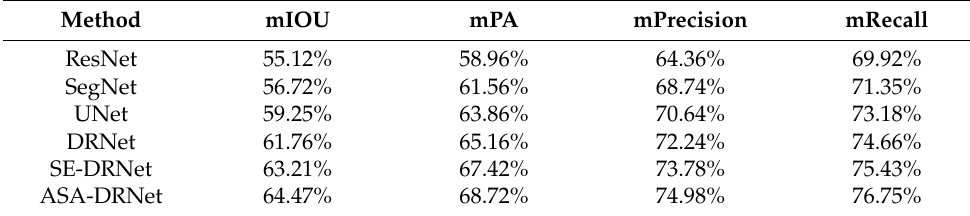
Table 3. Comparison of different initial contour extraction